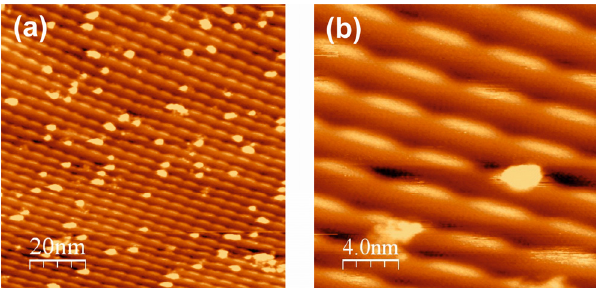
Figure 3. STM images of 0.07 ML of ceria on Au(788), deposited at 623 K and postoxidized at 473 K in 5 × 10 − 7 mbar O 2 . ( a ) (100 × 100) nm 2 ; V S = 2.2 V; I T = 14.7 pA. ( b ) (20 × 20) nm 2 ; V S = 2.2 V; I T = 14.7 pA. Note the brighter contrast areas that are associated with the fcc domains of the herringbone